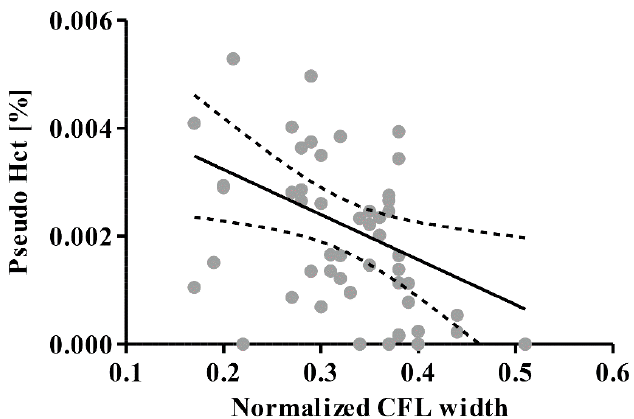
Figure 6. Pseudo hematocrit (Hct) of separated plasma as a function of CFL width. Solid and dashed lines represent a regression fit and 95% confidence band, respectively. Table 1. Plasma separation techniques.